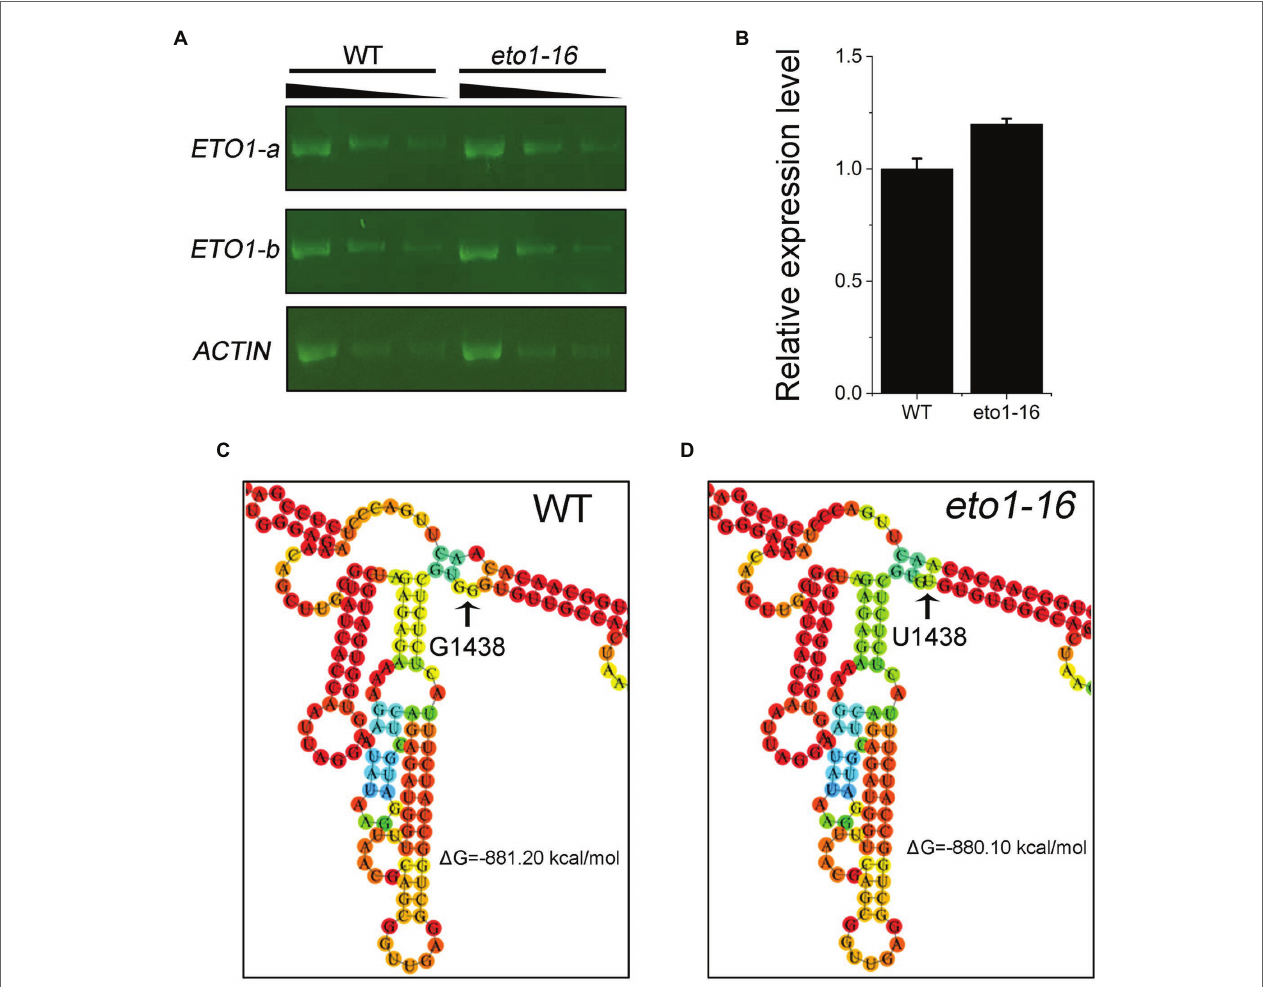
FIGURE 4 | Expression level and RNA folding structure of WT and mutant ETO1 transcripts. (A) Reverse transcription PCR (RT-PCR) results of ETO1-a , ETO1-b , and Actin7 transcript fragments in WT and eto1-16 . Black triangle (top) represents 3-fold serial dilutions of cDNA used for RT-PCR. (B) The relative expression levels of ETO1 in WT and eto1-16 quantified by quantitative real-time PCR (qRT-PCR). Partial predicted mRNA structure of ETO1 transcripts of WT (C) and eto1-16 (D)